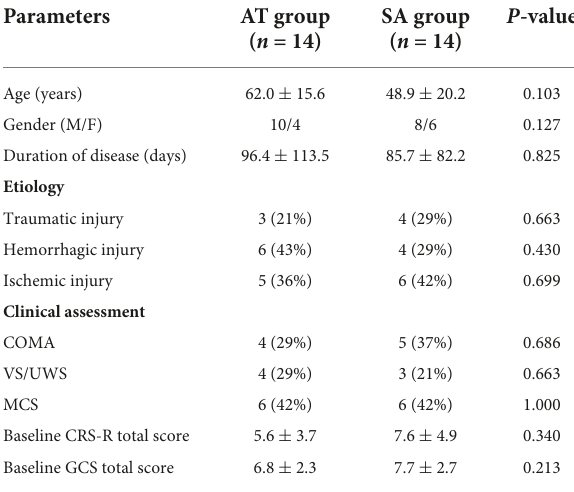
TABLE 1 Baseline characteristics.